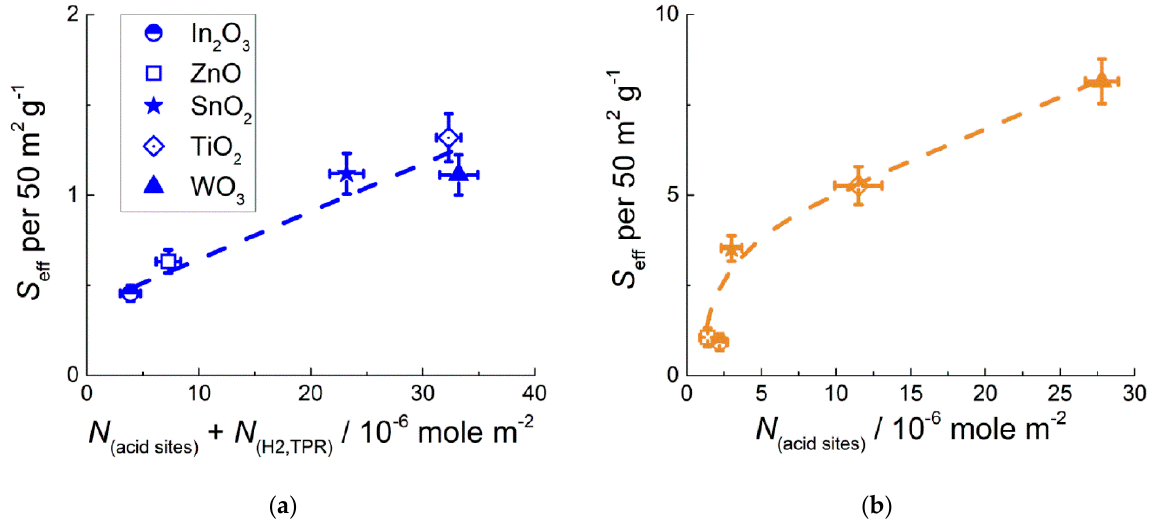
Figure 8. Maximum effective sensor signals to 2 ppm C 6 H 6 of: ( a ) pristine MOS in relation to summary concentration of acid sites and oxidative sites (in equivalents of H 2 consumed in TPR) and ( b ) PtO x − modified MOS in relation to concentration of acid sites at the surface of MOS.